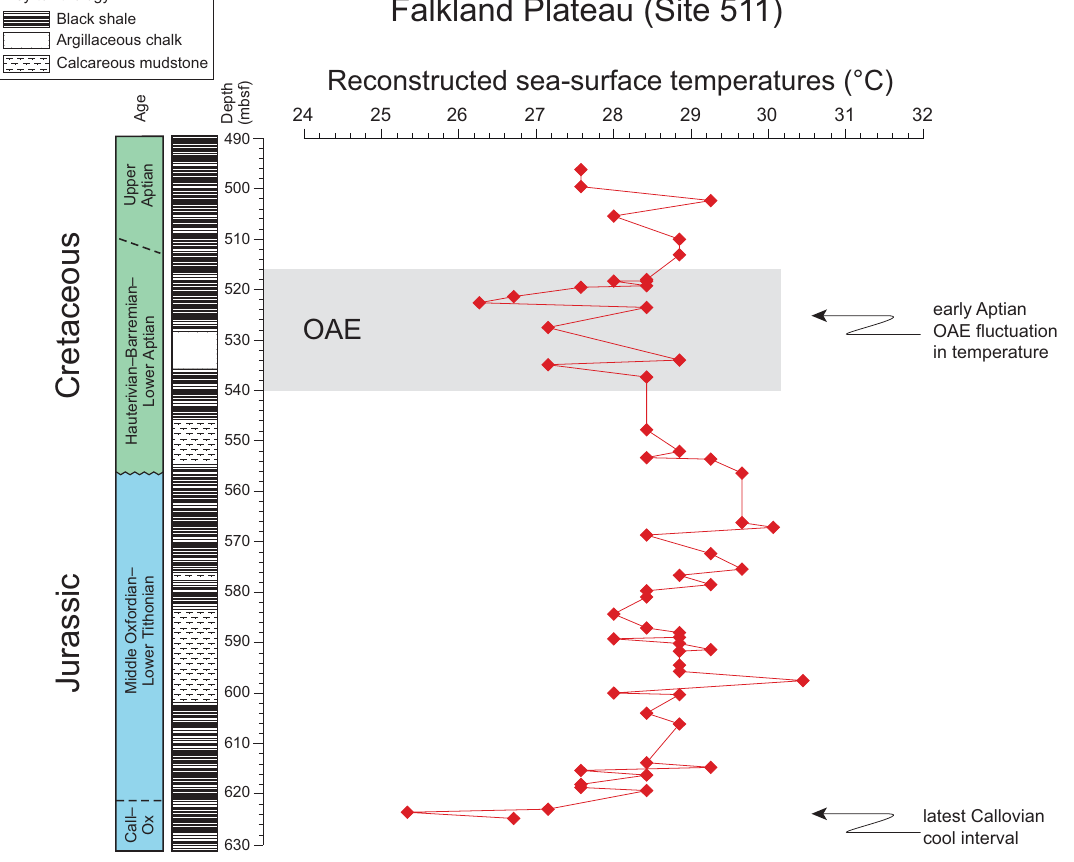
Fig. 4. Detailed illustration of sea-surface palaeotemperature evolution for the Middle Jurassic–Lower Cretaceous section on the Falkland Plateau (DSDP Site 511), using the equation of Kim et al. (2010). The evidence for drops in palaeotemperature in the late Callovian, early Aptian (after the onset of the OAE) and late Aptian conforms to globally recognized